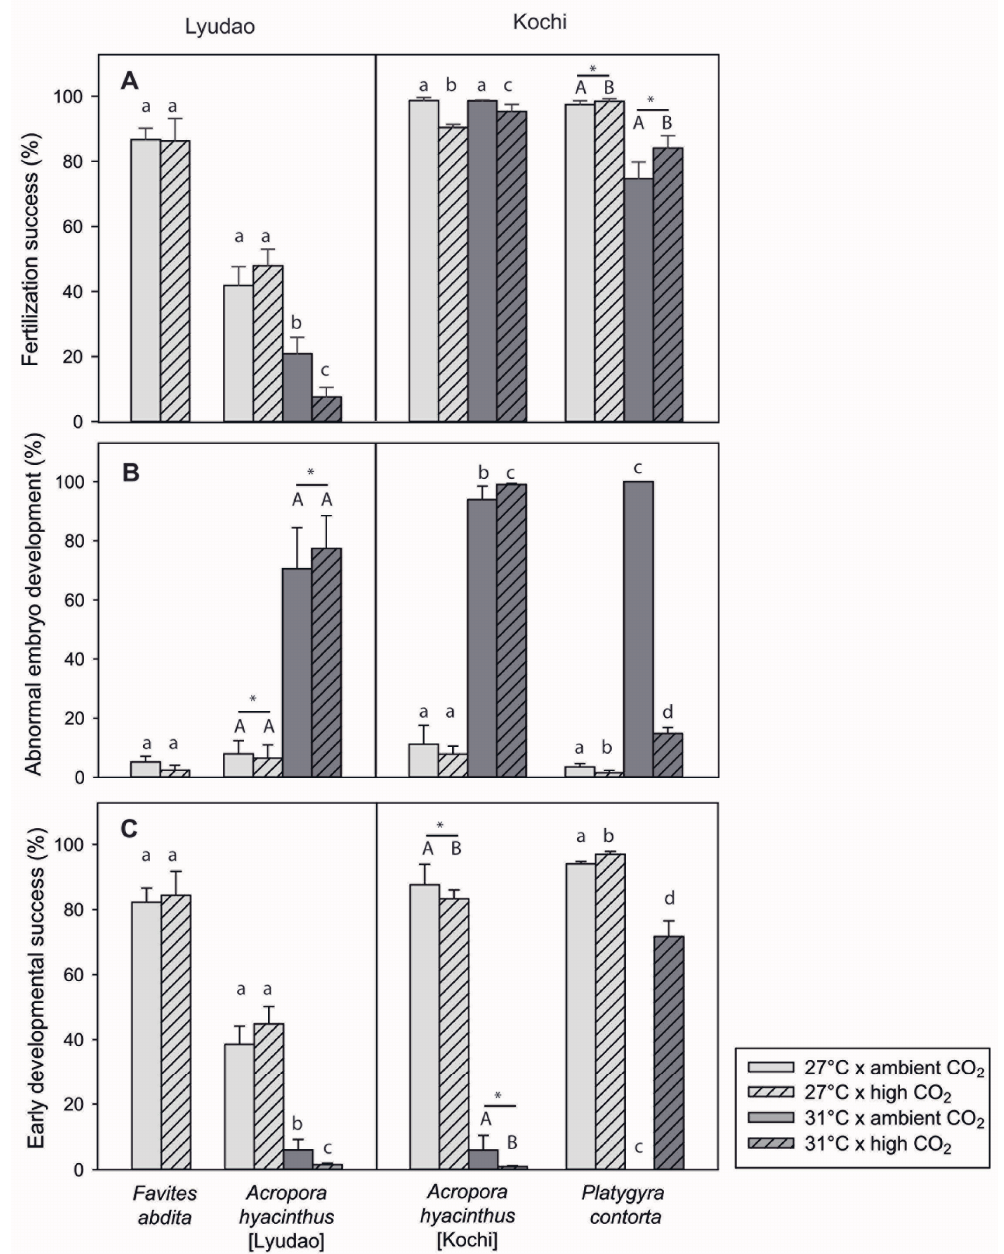
Figure 4. The effect of temperature (27 °C vs. 31 °C) and CO 2 level (400 vs. 1000 μ atm CO 2 ) on ( a ) the fertilization success, ( b ) abnormal development, and ( c ) early developmental success of different species in Lyudao and Kochi. Values are mean ± SD. Means lacking a common superscript differ significantly ( p < 0.05). Asterisks with bars mark significant main effects of temperature, whereas different capital letters mark significant main effects of CO 2 level. In those cases where a significant interaction between temperature and CO 2 level was detected, individual significant effects are marked by different lower case letters ( p < 0.05). See Table 1, 2, S2 and S3 for an overview of the